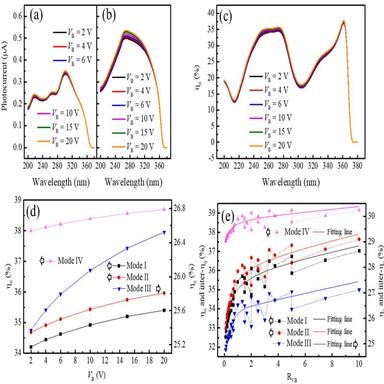
Photocurrent of MGPIN structure under (a) x-LP and (b) y-LP with different reverse bias voltages (VB). (c) Electrical anisotropy η of MGPIN with different VB. (d) Plot of electrical anisotropy η of each mode with different VB. (e) The changes of electrical anisotropy inter-ηij with different RVB= VBx / VBy.